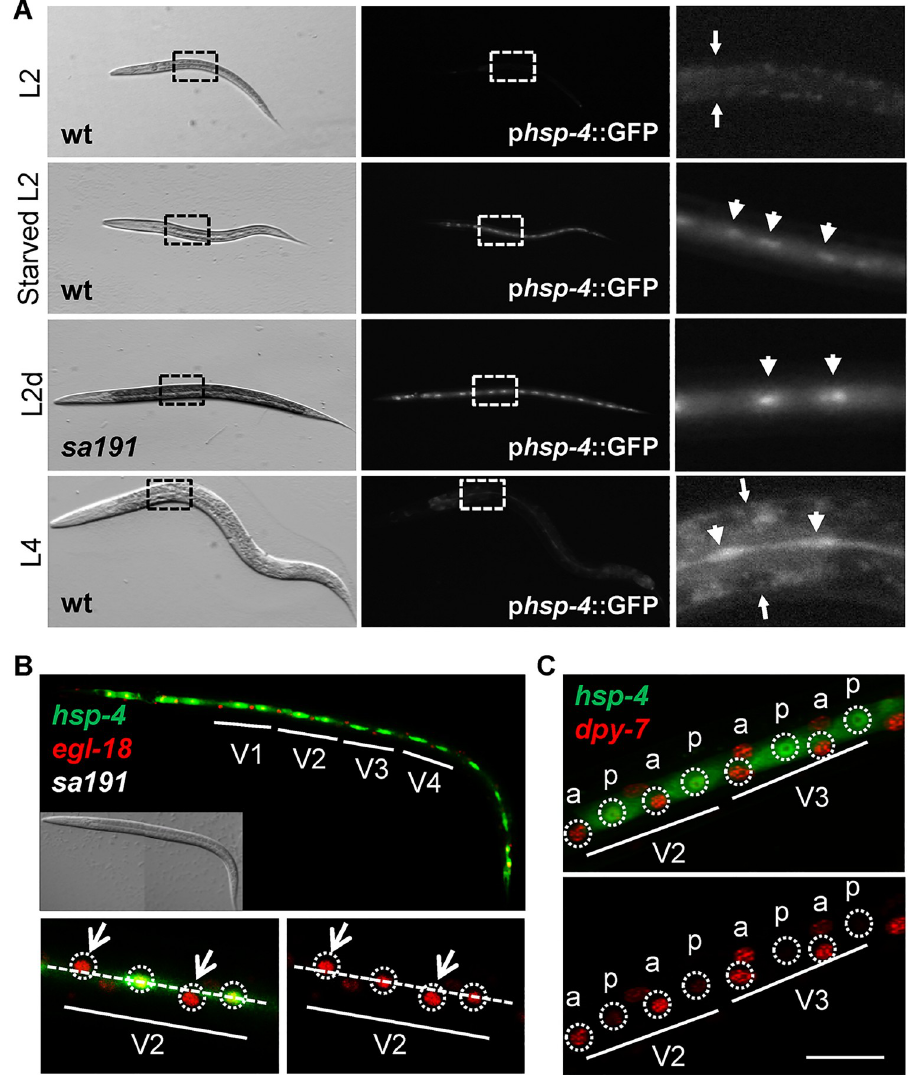
Fig 1. The UPR-inducible BiP homologue HSP-4 is induced during terminal differentiation of seam cells into alae-secreting cells. (A) Transmitted light and fluorescence micrographs of C . elegans expressing p hsp -4::GFP at indicated developmental stages. L2d stage animals are daf-28(sa191) . Images are taken at 120 × magnification on stereo microscope, under the same imaging conditions. Right panels show enlarged and (for L2 and L4 stages) overexposed boxed areas. Small arrows point to intestine boundaries, arrowheads point to individual seam cells. (B) Confocal image of daf-28(sa191) L2d animal expressing p hsp-4 ::GFP and p egl-18 ::H1-mCherry transgenes. Upper panel: projection of z-stack taken through the lateral hypodermis, lower panels: single-plane images. Lower panels show close view of V2 lineage cells, either in both channels or in red channel only, with nuclei circled. Open arrows point to anterior daughter cells, migrating away from the seam center line (dashed line). (C) Close view of V2 and V3 lineage cells of a starved L2 stage WT animal expressing p hsp-4 ::GFP and p dpy-7 ::HIS-24::mCherry transgenes. The anterior (a) and posterior (p) daughters of V2 and V3 seam-cell lineages are indicated, based on dpy-7 expression. Z-stack projection, scale bar: 20 μ m. BiP, immunoglobulin heavy chain-binding protein; daf-28(sa191) , an allele causing ectopic L2d entry; GFP, green fluorescent protein; HIS-24, histone; HSP-4, Heat-Shock Protein 4; L2, second larval stage; L2d, predauer L2; L4, fourth larval stage; p dpy-7 , dpy-7 promoter, active in hypodermal cells; p egl-18 , egl-18 promoter, active in the posterior seam cells after asymmetric divisions; UPR, unfolded protein response; WT, wild type.